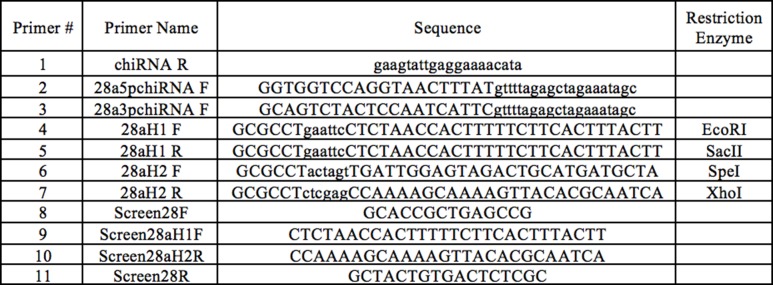
CRISPR mutant cloning and verification primers.Primers #1–3 were used for creating CRISPR Guide chiRNA, primers #4–7 were used for constructing the CRISPR donor plasmid, and primers #8–11 were used to verify Obp28a deletion in transgenic flies.